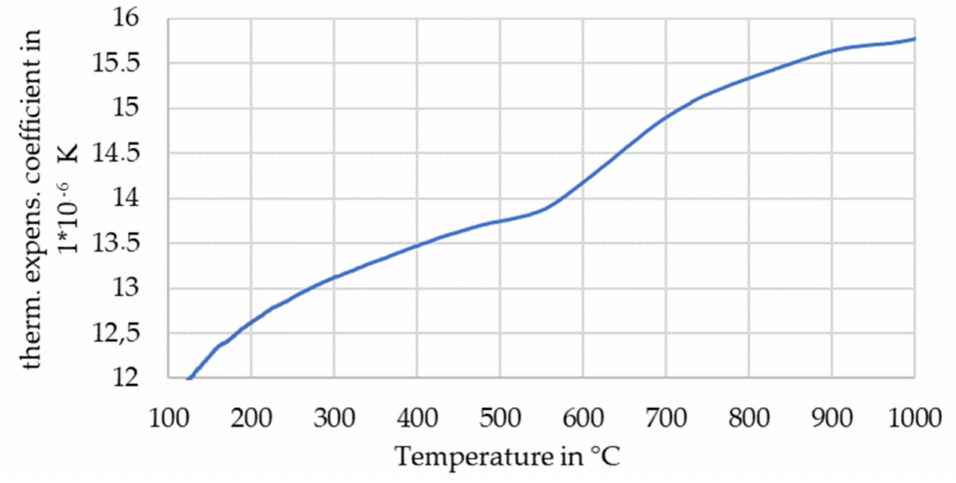
Figure 12. Thermal expansion coefficient over